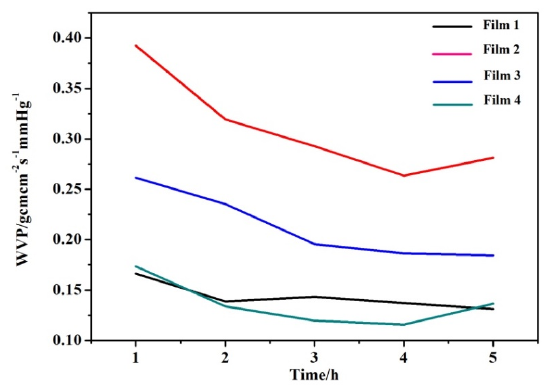
Figure 9. The water vapor permeability of blend Film 1, Film 2, Film 3, and Film 4.